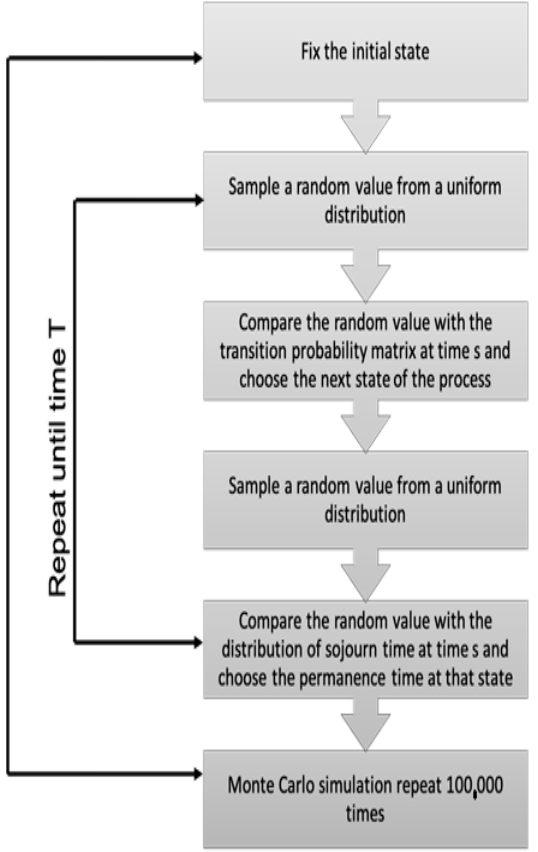
Figure 1. Algorithm for the simulation of non-homogeneous semi-Markov trajectories.